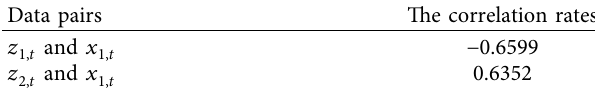
Table 1: Descriptive statistics of each data. Table 2: Te correlation rates between z